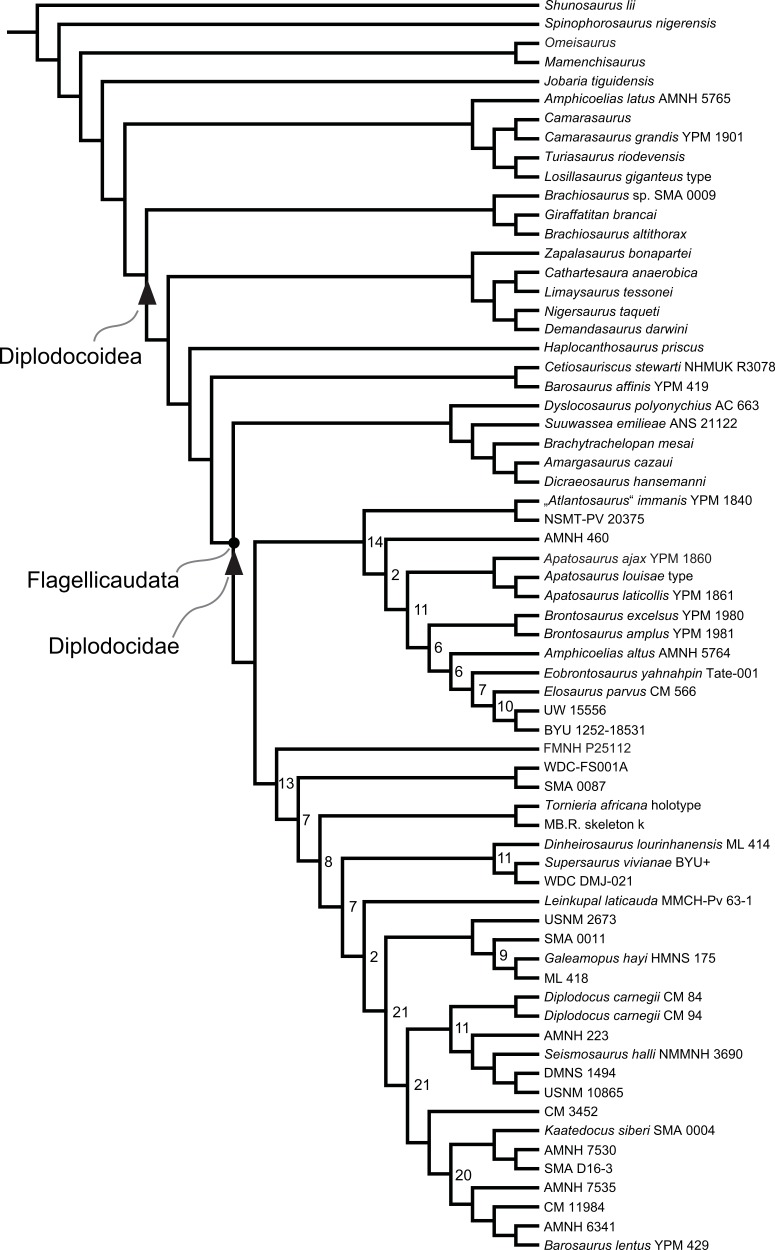
Reduced consensus tree obtained by equal weighting.Fifteen OTUs were deleted a posteriori. Numbers at the nodes indicate the number of changes between the two branches departing from the node (for the apomorphy count).